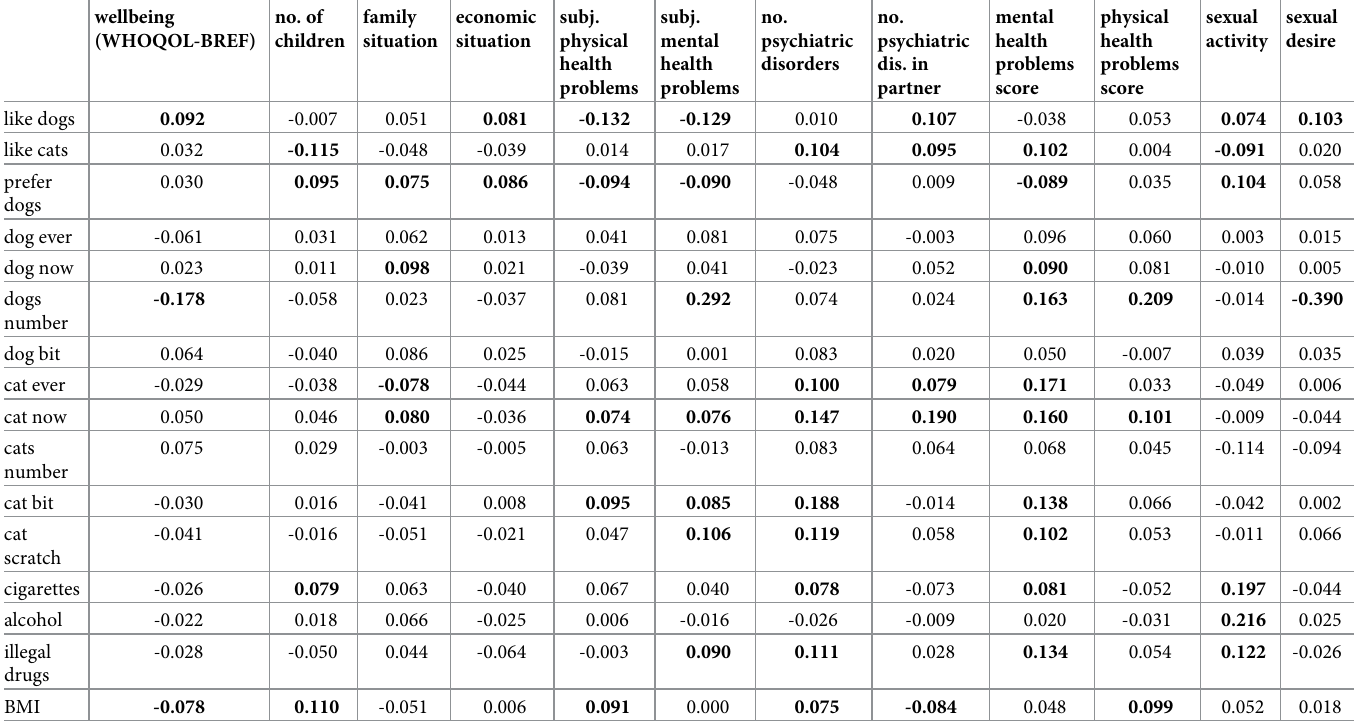
Table 6. Association of animals-related variables with wellbeing and health of Toxoplasma -free male responders. wellbeing no. of family economic (WHOQOL-BREF) children situation